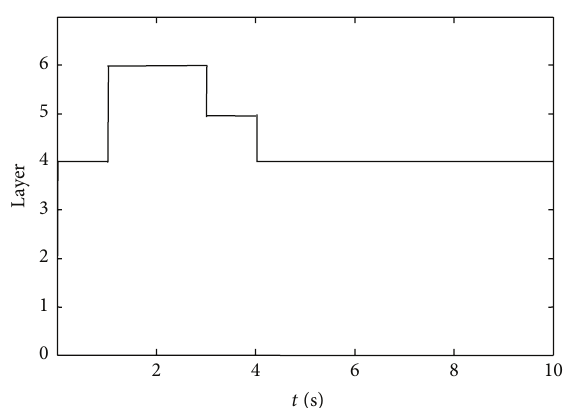
Figure 8: The structure of the node